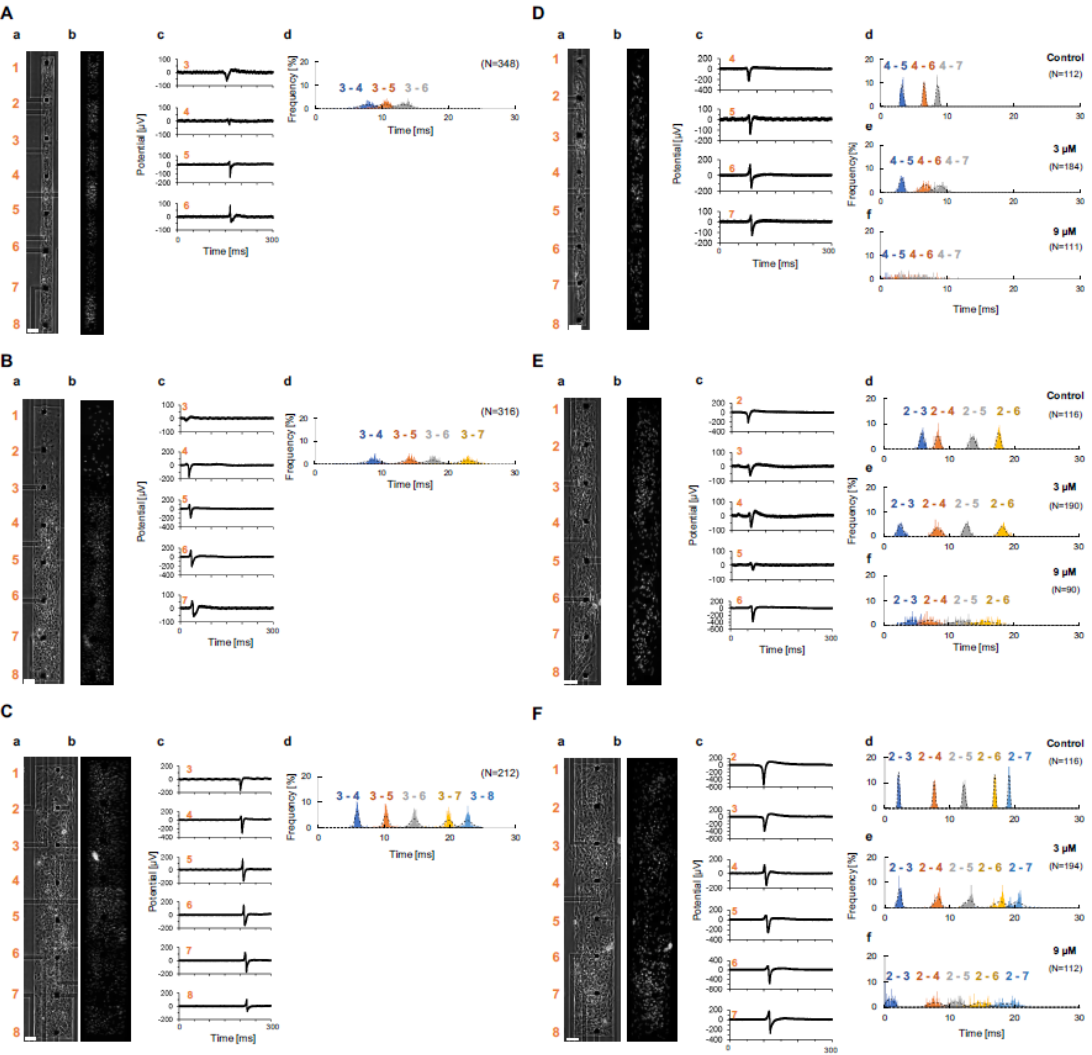
Figure 2. Propagation manner of linear mouse primary cardiomyocyte network and human embryonic stem cell-derived (hES) cardiomyocyte network. ( A – C ) Mouse primary network in 100 µm width (D), 200 µm width (E), 300 µm width (F). (a) Phase-contrast micrograph of mouse primary cardiomyocytes network with 2100 µm in length. Microelectrodes for measuring the external field potential were set 300 µm interval. The left numbers represent the associated microelectrodes. (b) Fluorescent micrograph of mouse primary cardiomyocytes in the network. The nuclei of each cell were stained by 4’,6-Diamidino-2-phenylindole dihydrochloride (DAPI). (c) Examples of Extracellular field potential signals of microelectrodes. The red numbers represent microelectrodes shown in (a). (d) Histograms of propagation time between specific two electrodes. ( D – F ) hES cardiomyocyte network in 100 µm width (A), 200 µm width (B), 300 µm width (C). (a) Phase contrast micrograph of hES cardiomyocyte network with 2100 µm in length. Microelectrodes for measurering the external field potential were set 300 µm interval. The left numbers represent the associated microelectrodes. (b) Fluorecent microgragh of hES cardiomyocytes in the network. The nuclei of each cells were stained by DAPI. (c) Examples of extracellular field potential signals of microelectrodes. The red numbers represent microelectrodes shown in (a). (d–f) Histgrams of propagation time between specific two electrodes; 0 µM Quinidine (Control) (d), M3 µM Quinidine (e), and 9 µM Quinidine (f), respectively. N represents beating number. Bars, 100 µm.